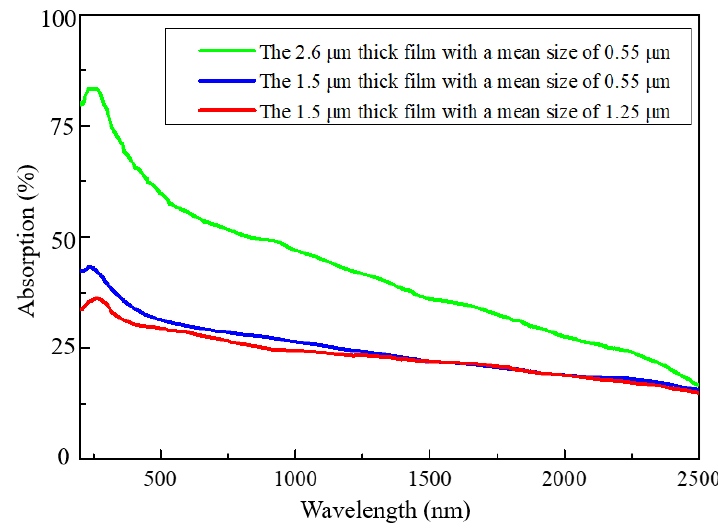
Figure 4. UV – VIS – NIR absorption of the 6H-SiC films with different thicknesses and MNC sizes. Due to the wide MNC size distribution, the absorption spectra are broad and have large intensities in the range of visible light. The strongest absorption appears in the film with the largest thickness and meantime with the smallest MNC sizes. The smaller the MNC sizes, the larger the specific surface area and thus the stronger the surface plasmons.